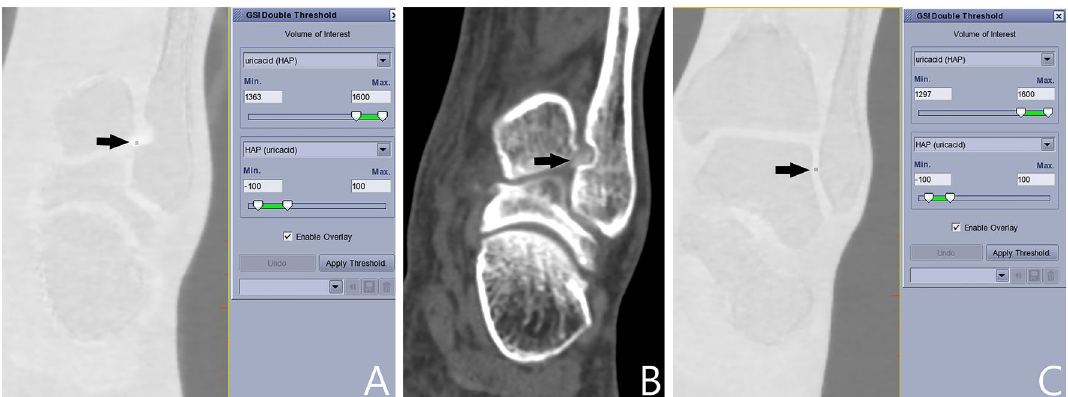
Figure 5. Comparison of MLLSV in ankle joint. MLLSV [arrow in ( A )] in left ankle joint is 1363 mg/cm 3 for a 45 years old male gout patient with left ankle pain. There is a tophus [arrow in ( B )] in the region stained in ( A ). MLLSV [arrow in ( C )] in left ankle joint is 1297 mg/cm 3 for a 47 years old male healthy volunteer. MLLSV in gouty joint is obviously higher than that in the normal